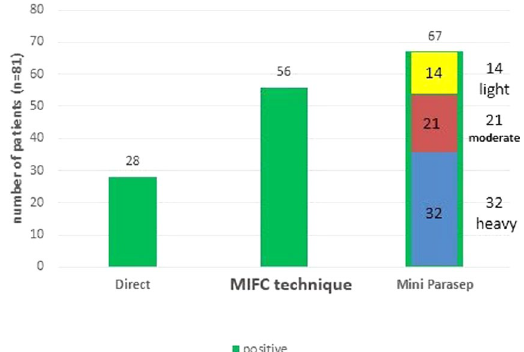
Figure 2. Detection of G. lamblia cysts in stool samples of human by direct smear, MIFC technique and Mini- Parasep.